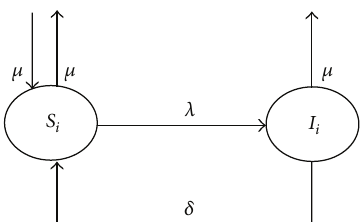
Figure 1: State transition graph of the 𝑖 th kind of mobiles in M-SIS